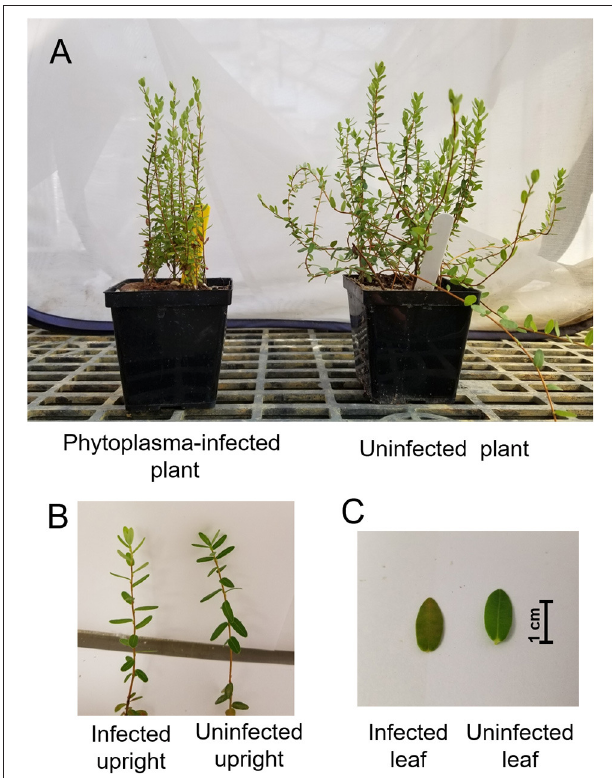
FIGURE 1 | Morphological differences (A) and close-ups of uprights (B) and leaves (C) of phytoplasma-infected and uninfected cranberry ( Vaccinium macrocarpon )